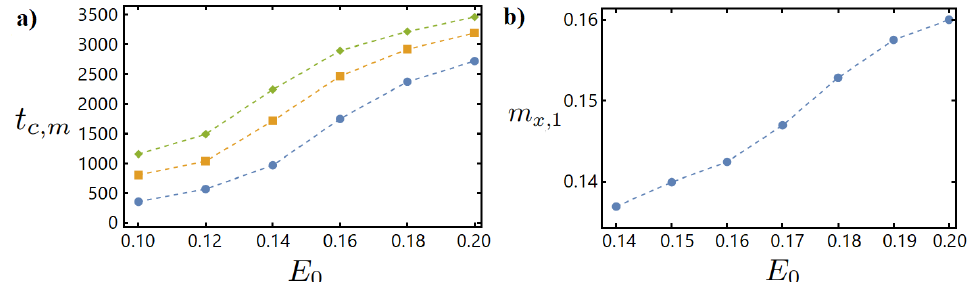
Figure 8: a) Critical time t as a function of E , for r = 640 and: τ = 750 (blue c , m 0 curve), τ = 1000 (orange curve), τ = 1200 (green curve); b) order parameter m as a function of E , for r = 640 and τ = 1200 at t = 2000 (measured from the peak 0 of the pulse t max